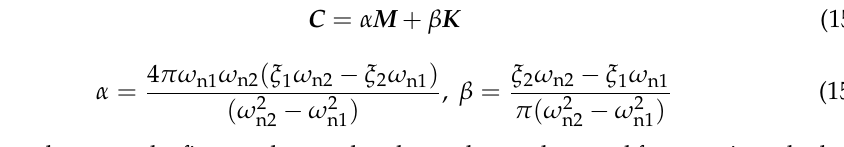
where q = [ x 1 , y 1 , θ x 1 , θ y 1 , . . . , x 18 , y 18 , θ x 18 , θ y 18 ] T is the generalized displacement vector. M and G are the constant components of the global mass matrix and gyroscopic matrix,